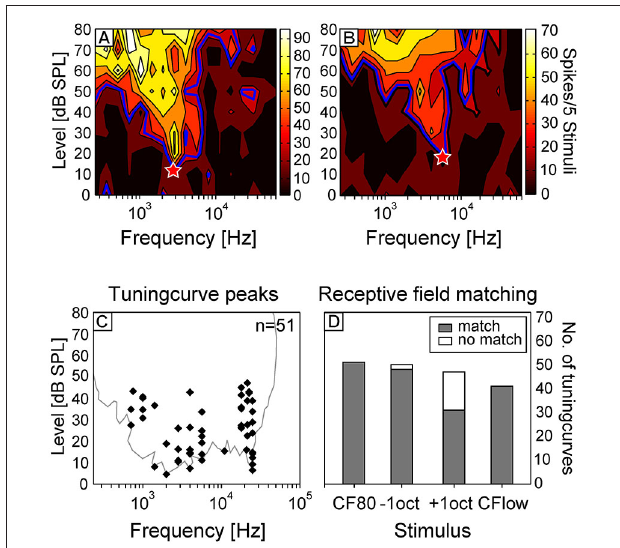
FIGURE 3 | Analysis of receptive fields of cortical neurons. Representative tuning curves of two neurons of different animals are displayed in the upper row [characteristic frequency (CF; red asterisks) = 2.8 kHz (A) ; 5.7 kHz (B) ]. Tuning curves were interpolated at 30% of the maximum spike rate. (C) CF displayed against minimum threshold (MT) of all tuning curves measured at layer V/VI of each cortical site. In the background the outline of all shapes of respective receptive field is plotted. Only neurons with sensitive receptive fields (MT below 50 dB SPL) were selected for this study. (D) The percentage of receptive fields matching with the respective frequency content of the four